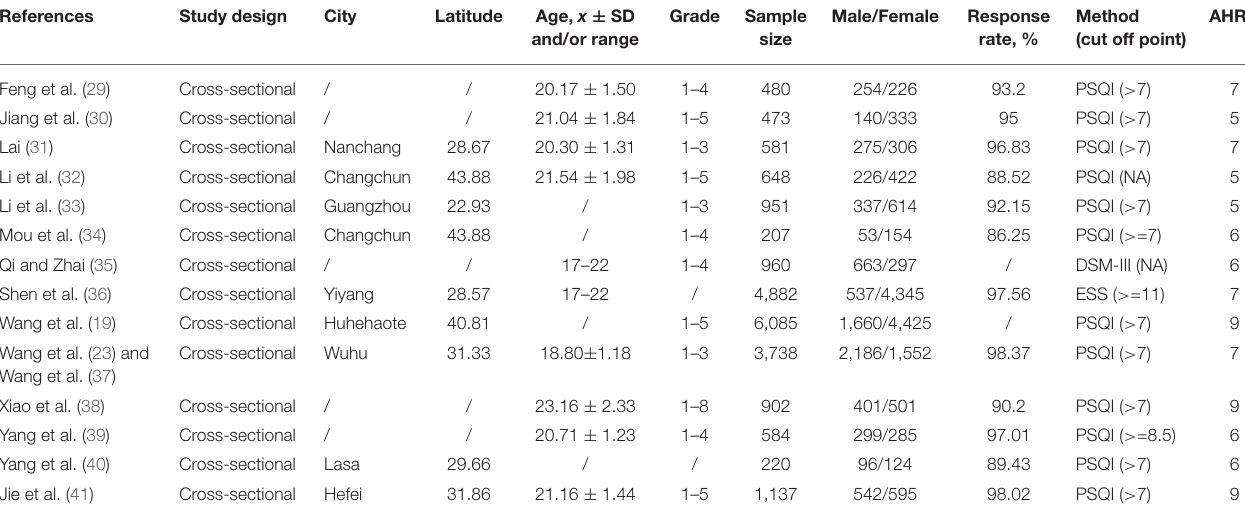
TABLE 1 | Characteristics of the included